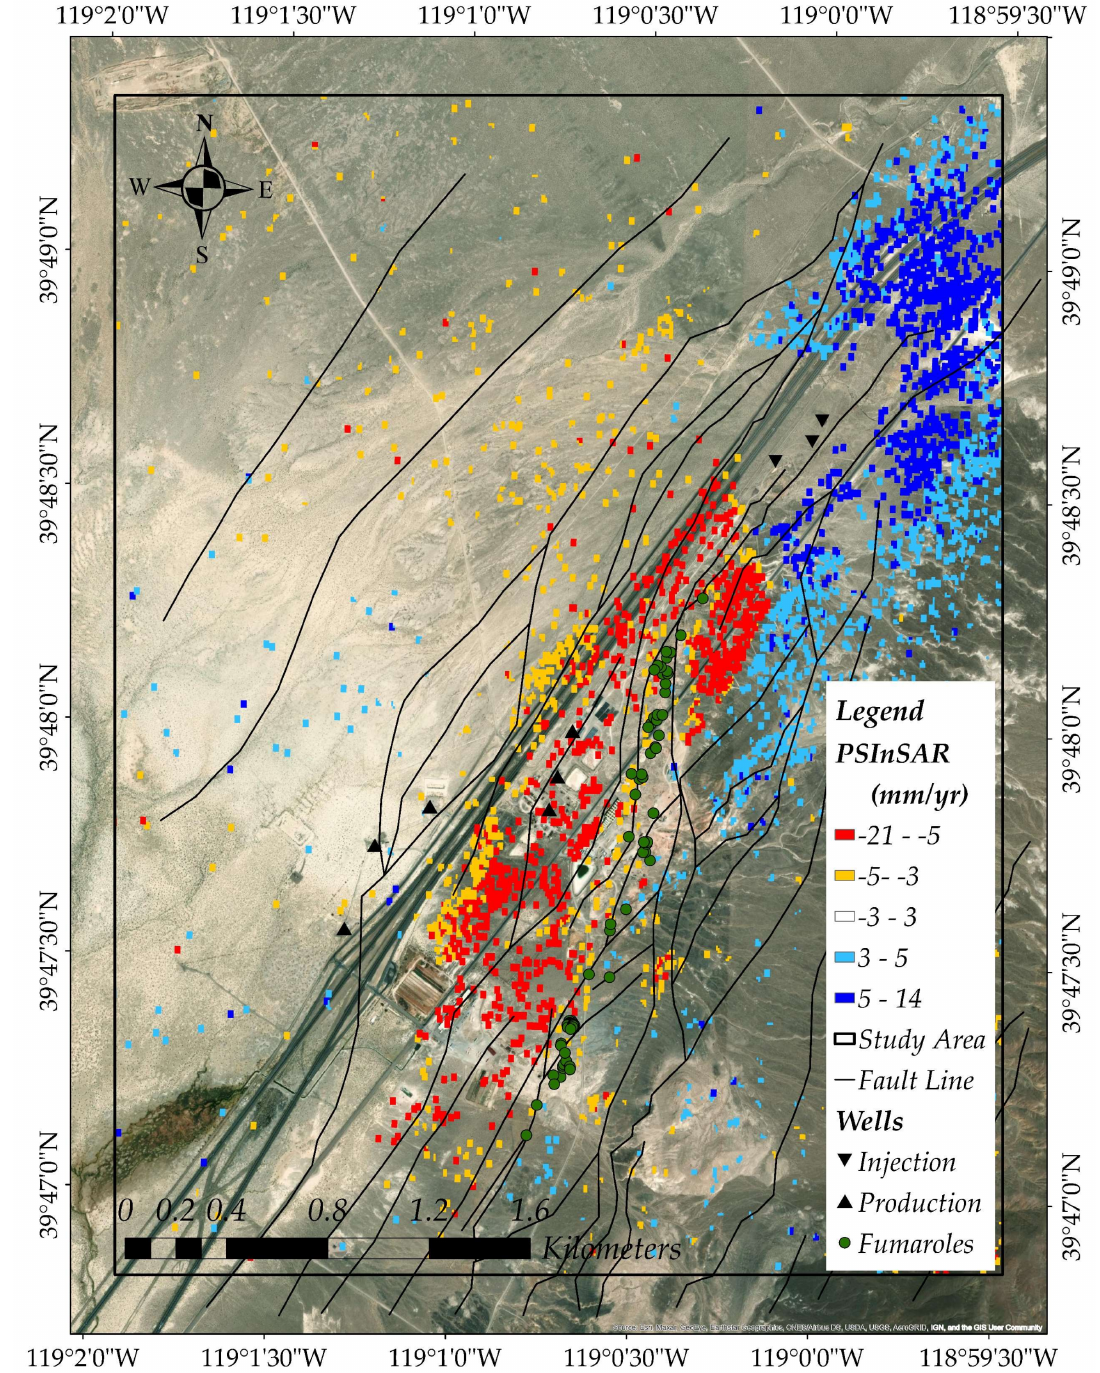
Figure 6. The PSI analysis of Brady’s field with 70 images ( ± 3 mm/yr displacement values are not shown as accepted as